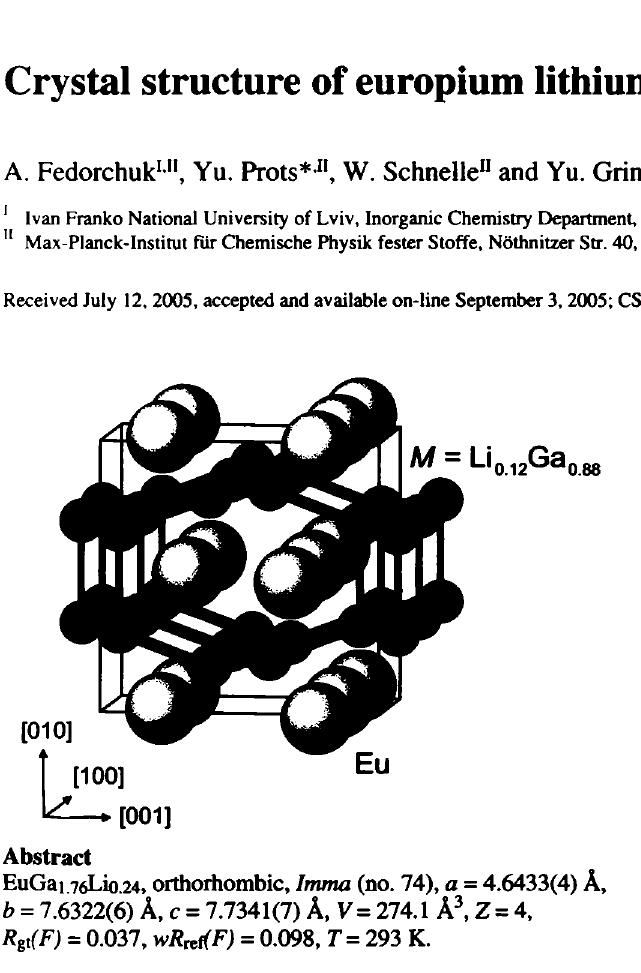
EuGai.76Lio.24, orthorhombic, Imma (no. 74), a = 4.6433(4)